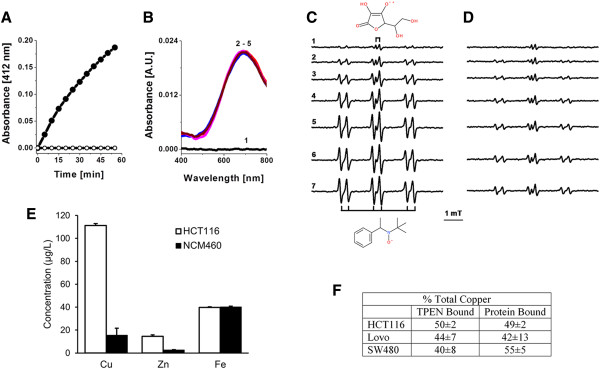
TPEN-Cu complex is redox active. A) Reduction of [TPEN-Fe (III)] and [TPEN-Cu (II)] by ascorbic acid. Reactions were carried out at 25°C in 0.1 M phosphate buffer (pH 7.4). TPEN, ferric nitrate, copper sulfate and ascorbic acid were used at concentrations of 0.2, 0.1, 0.1 and 5 mM, respectively. Complexes of TPEN with Cu (II) and Fe (III) were prepared via incubation of the ligand (0.3 mM) with the corresponding metal ion (0.03 mM) for 10 min in the reaction buffer. A) Changes in the absorbance of solutions of [TPEN-Fe(III)] in the absence (open circles) and the presence (closed circles) of ascorbic acid. B) Electronic spectrum of TPEN (1) and [TPEN-Cu(II)] in the absence (2) and the presence (3 – 5) of ascorbic acid. Consecutive spectra were recorded with time interval of 5 min. C-D) Fenton-like reactions of [TPEN-Cu(II)] and [TPEN-Fe(III)]. C) [TPEN-Cu(II)], ascorbic acid, DMSO, H2O2 and PBN. D) [TPEN-Fe(III)], ascorbic acid, DMSO, H2O2 and PBN. Reactions were carried out 25°C in 0.1 M phosphate buffer (pH 7.4). Ascorbic acid, DMSO, H2O2 and PBN were used at concentrations of 1 mM, 300 mM and 2 mM, respectively. Consecutive EPR spectra were recorded with time interval of 5 min. E) Concentrations of copper, zinc and iron in HCT116 and NCM460 (mean ± SD, n = 3). F) Percent copper chelated by TPEN in HCT116, Lovo and SW480 cells. Cells were treated with 5 μM TPEN for 24 h, and prepared cell lysates were filtered through 10 Kd cut off filtered to remove TPEN and TPEN-copper complexes. Copper was measured by atomic absorption in both the filtrate (TPEN Bound) and the lysates (Protein Bound) and percentages calculated accordingly (mean ± SD, n = 3).